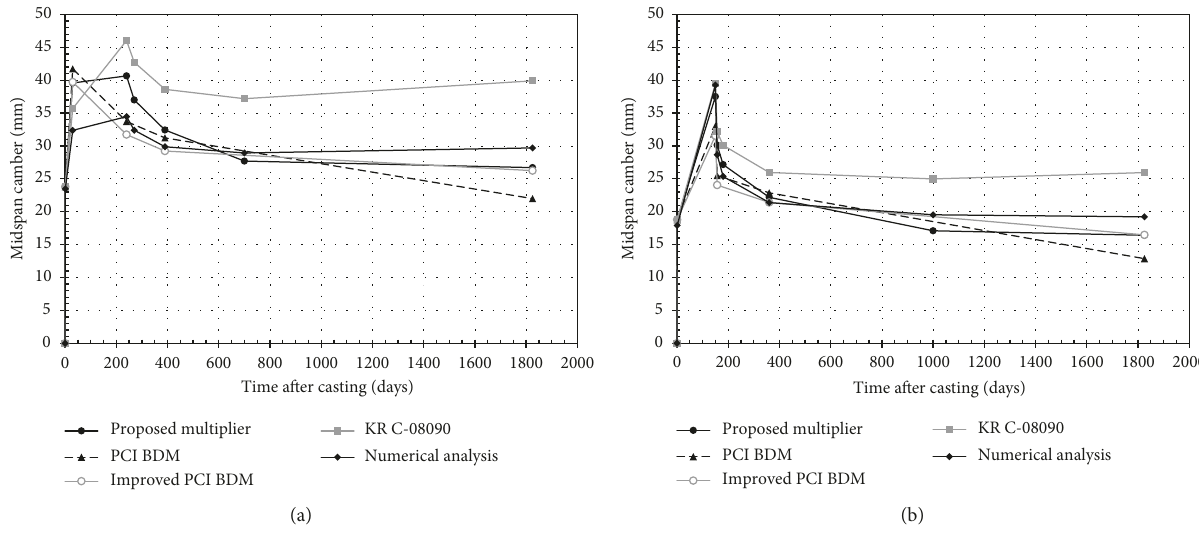
Figure 5: Comparison of various predictions for bridges (a) A and (b)